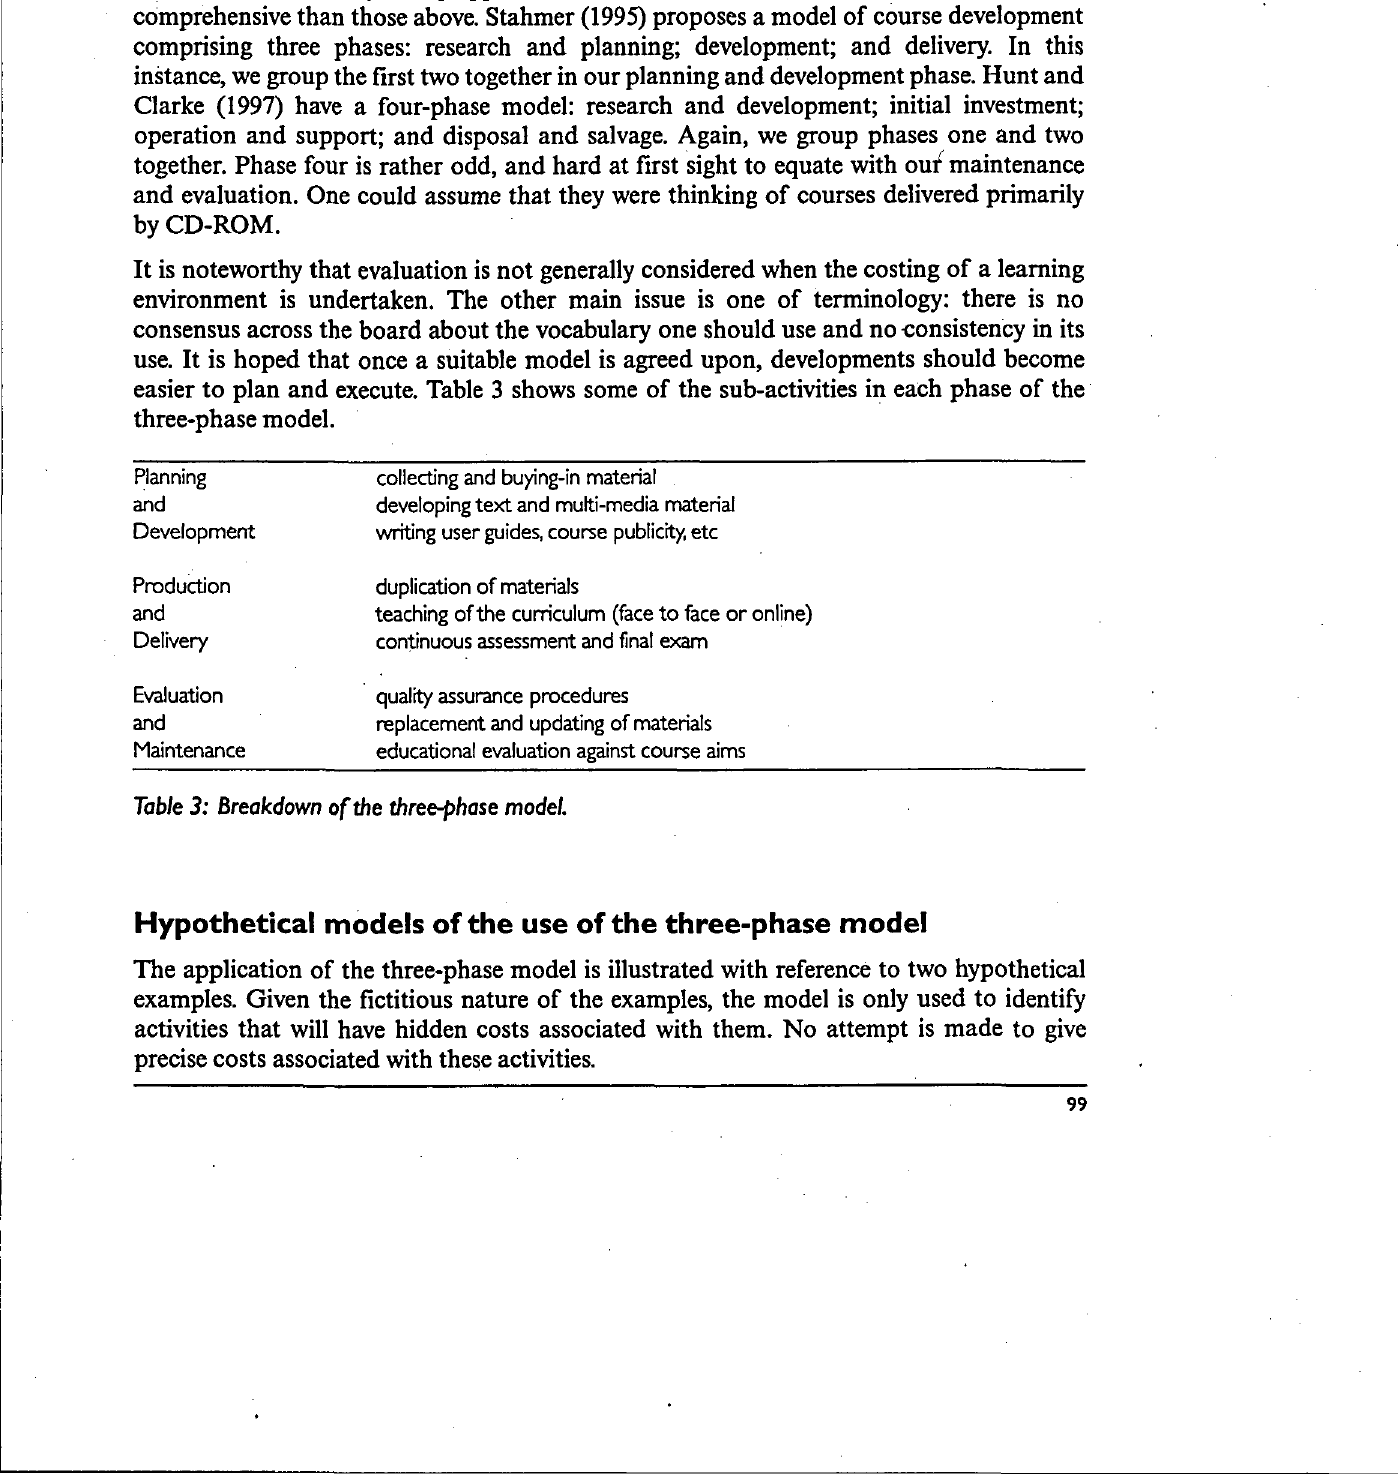
Hypothetical models of the use of the three-phase